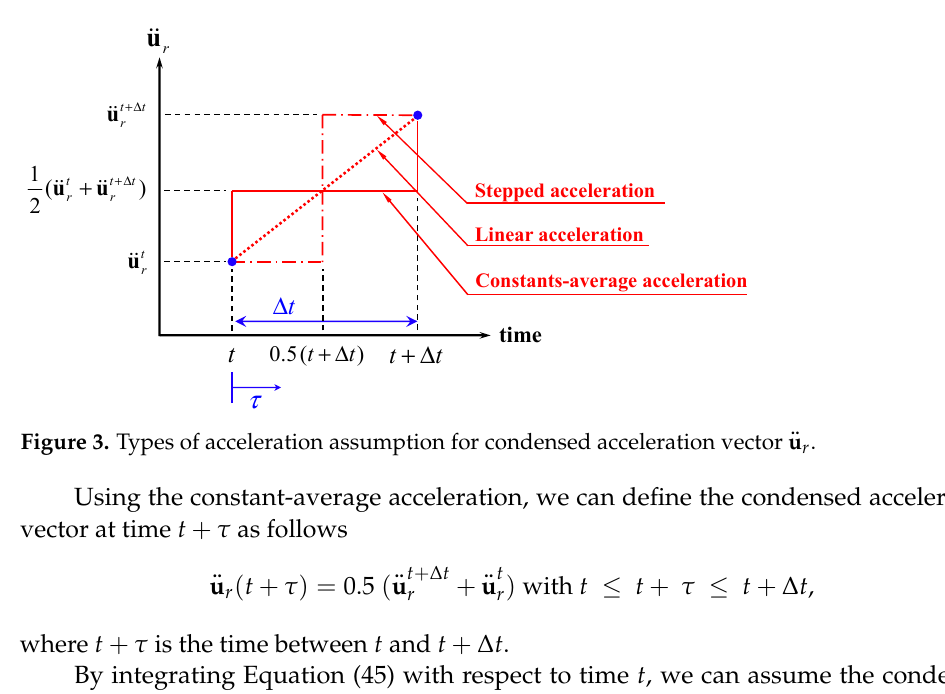
Figure 3. Types of acceleration assumption for condensed acceleration vector r u